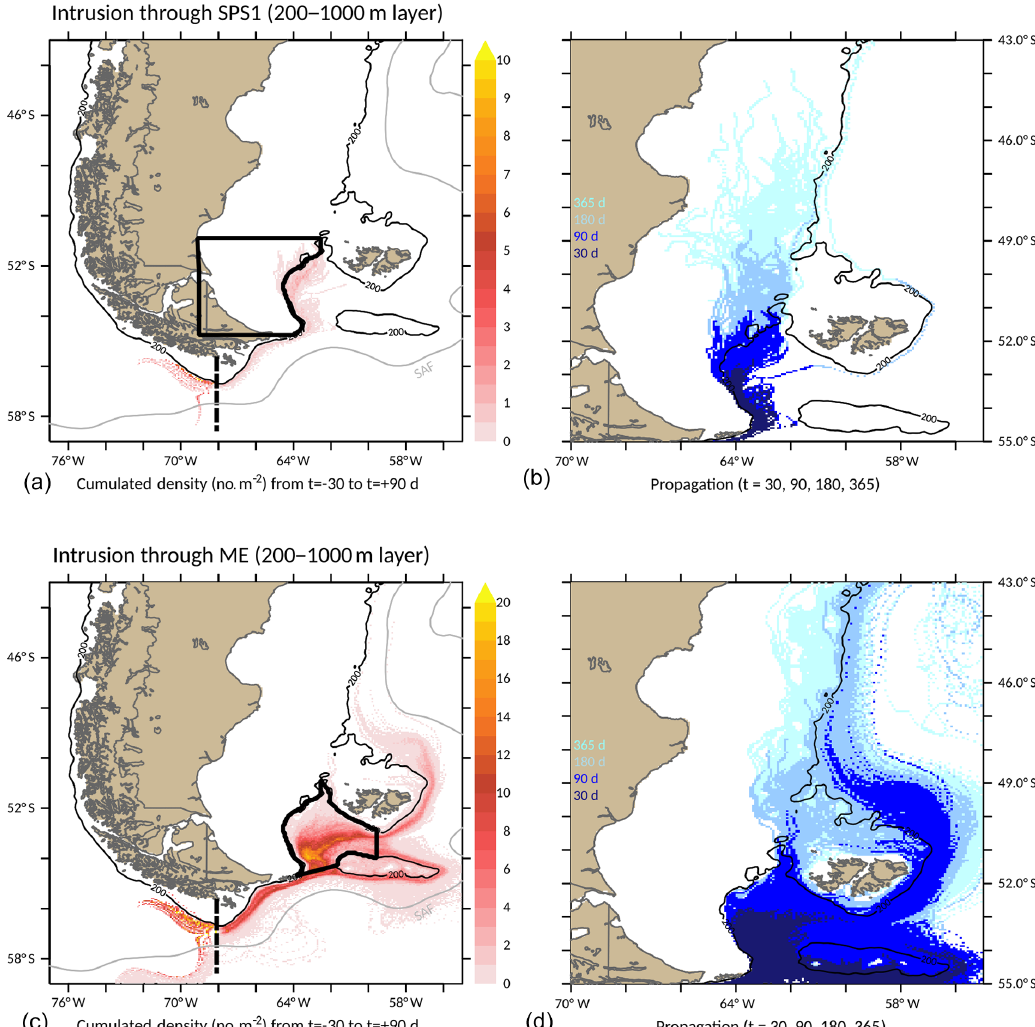
Figure 8. Pathways of the monthly release of particles at Cape Horn (68.1 ◦ W, from 58.5 ◦ S to the coast) on the 200–1000m layer. Arrival at the Atlantic section through (a, b) SPS1 and (c, d) the Malvinas Embayment. Simulations are run backward for 30d and forward for up to 365d. (a, c) Cumulative square-meter density (number of particles per square meter), which is the cumulative spatial distribution after 324 simulations of 90d. The dotted line at 68.1 ◦ W shows the release section, and the black area shows the SPS1 and Malvinas Embayment areas, respectively. (b, d) Colors show the propagation of the advected particles after 30, 90, 180, and 365d from dark to light